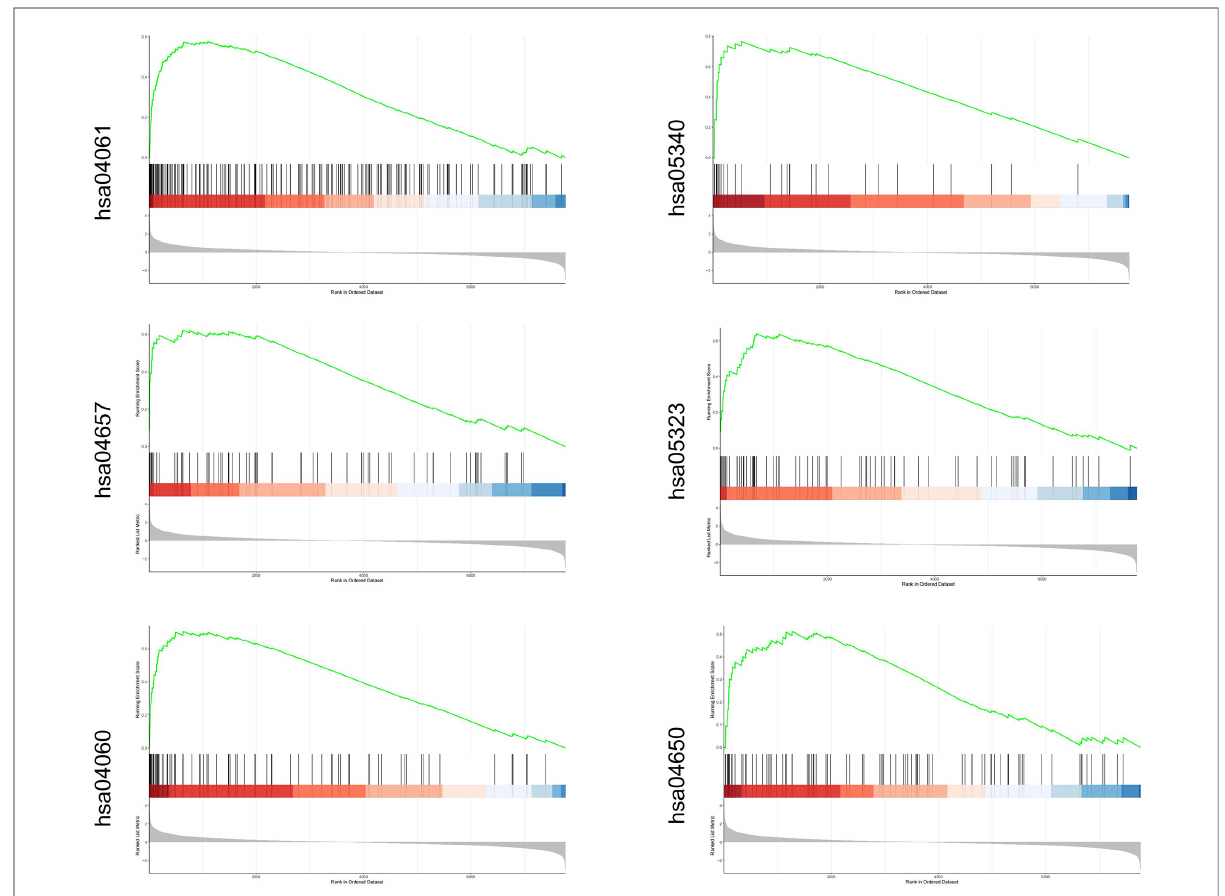
FIGURE 2 DEG enrichment pathway obtained from the combined database and further veri fi ed by